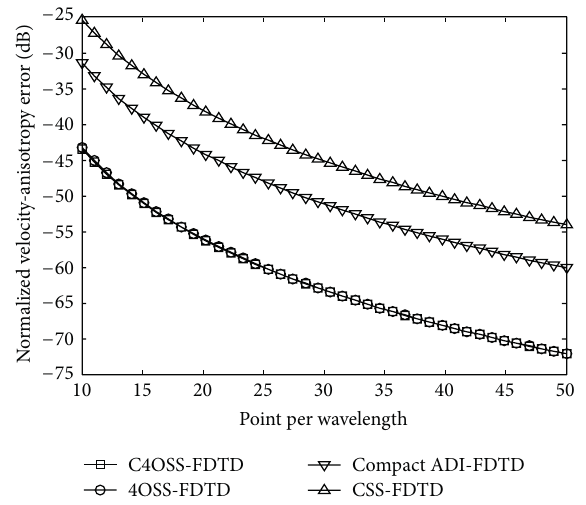
Figure 1: Normalized phase velocity of C4OSS-FDTD and 4OSS- FDTD ( 𝑁 𝜆 = 20 , CFLN = 1, 2, 4).